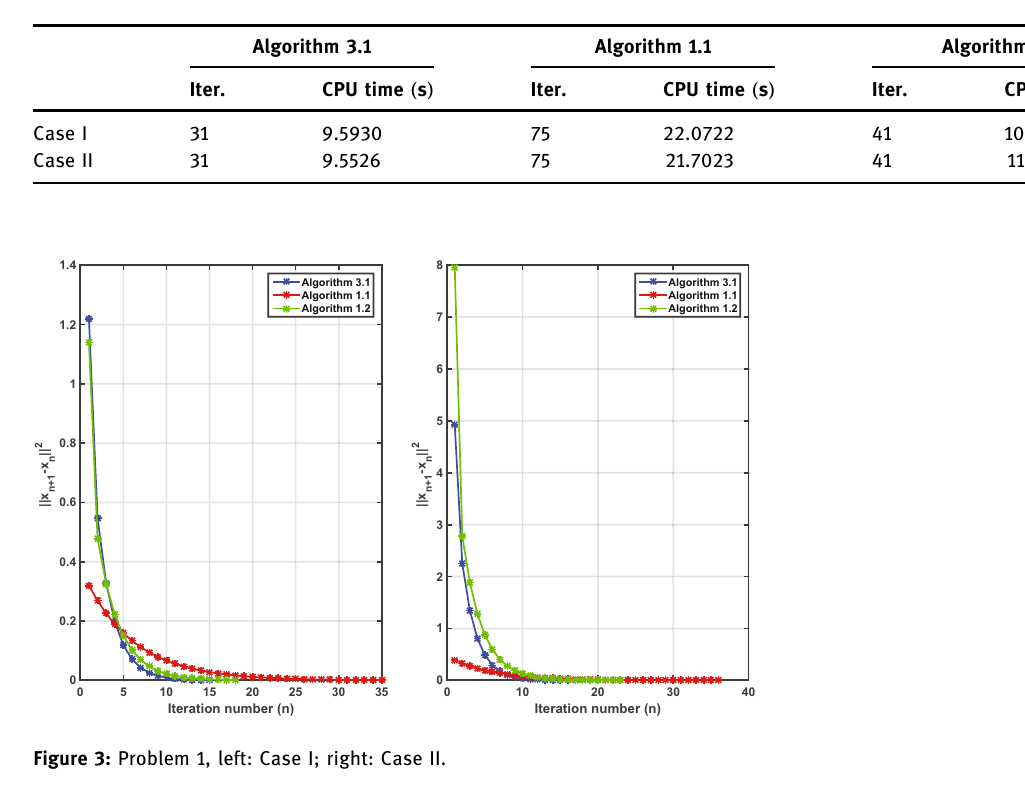
Algorithm 3.1 Algorithm 1.1 Algorithm 1.2